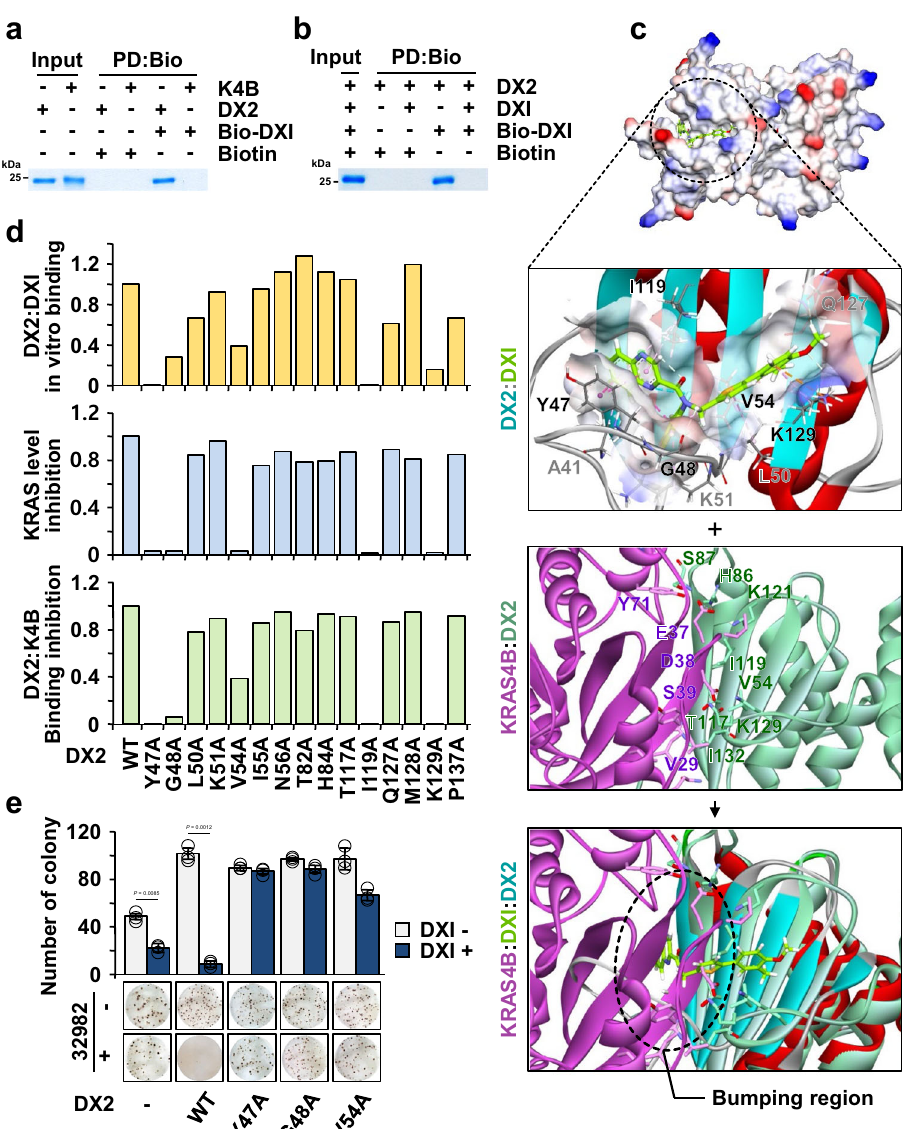
Fig. 6 Mode of action of BC-DXI-32982. a In vitro pull-down assay showing the direct binding of DXI with DX2, but not with KRAS4B. Proteins co- precipitated with Biotin-DXI #2 (Bio-DXI) were determined by SDS-PAGE and Coomassie staining. Biotin was used as a negative control. Results are representative of at least three independent experiments. b In vitro pull-down assay showing the speci fi c interaction of compound with DX2 using Bio-DXI and DXI. Results are representative of at least three independent experiments. c Binding mode of DXI to DX2 as obtained from the MD simulation. The representative structure at 371.2 ns is shown as an electrostatic surface model ( fi rst from above). Zoomed-in view of the detailed interactions is presented and binding residues of the compound (green) were depicted as a stick model (second from above). MD snapshots of DX2 and KRAS4B complex at 533.7 ns (third from above). Overlay of above two MD snapshots by superimposing over DX2. The dashed circle denotes the contact region proposed to be responsible for the DXI-mediated inhibition of the interaction of DX2 with KRAS4B (bottom). d Graphs showing the critical residues of DX2 for binding with DXI. Results from the in vitro binding of DX2 mutants with DXI; compound-mediated change in KRAS levels and inhibition of DX2 mutants-KRAS4B were quanti fi ed (Supplementary Fig. 13n – p). e Anchorage-independent colony formation assay validating the signi fi cance of the binding between DXI and DX2. Representative images are shown (bottom). The experiment was independently repeated thrice and error bars denote S.D. Data are presented as mean values ± S.D. P value is from the two-sided t test. Source data are provided as a Source data fi drug development 9,61 , an alternative approach to deal with diverse KRAS-driven cancers still needs to be devised. While a vast amount of genetic data is available for the cancer-associated KRAS gene, how KRAS is controlled at the post-transcriptional level is not well understood. Here, we show a tumor-promoting stabilization mechanism of KRAS via another oncogenic protein, DX2, and propose the interface of the two oncogenic factors as an alternative and effective route to control KRAS-driven cancers.